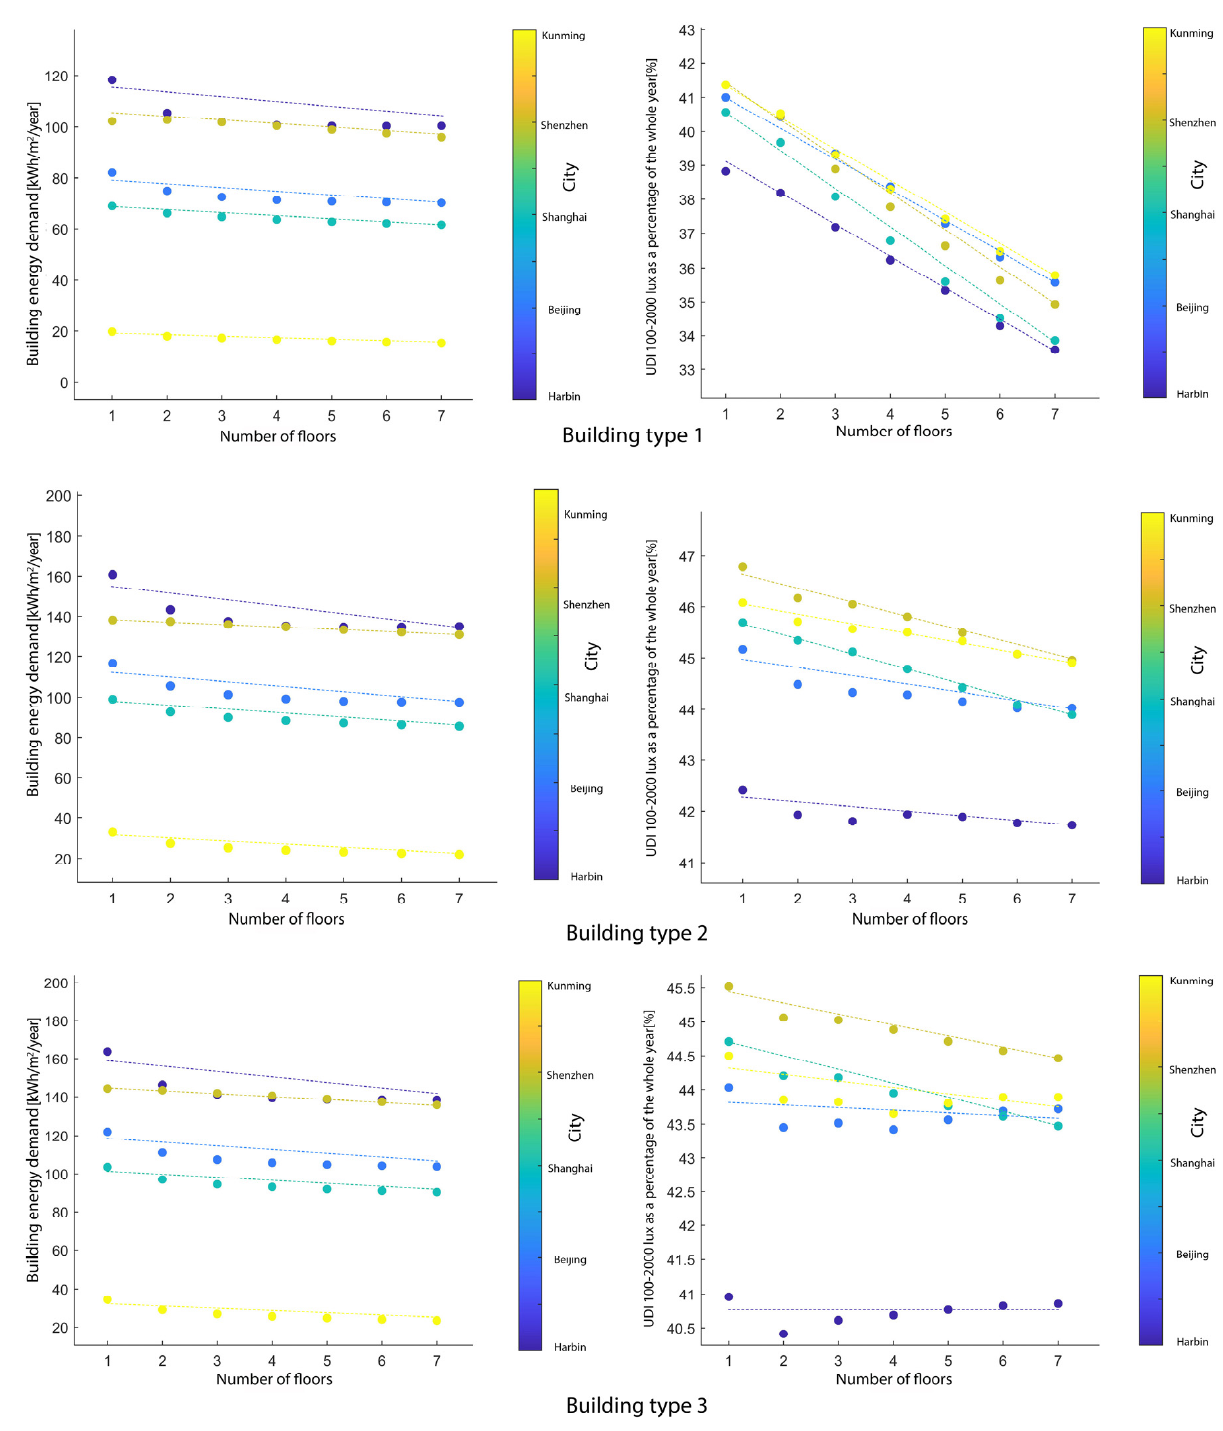
Figure 28. Relationship between the number of floors and the building energy demand ( left ) and the relationship between the number of floors and the lighting environmental comfort ( right ) for three building